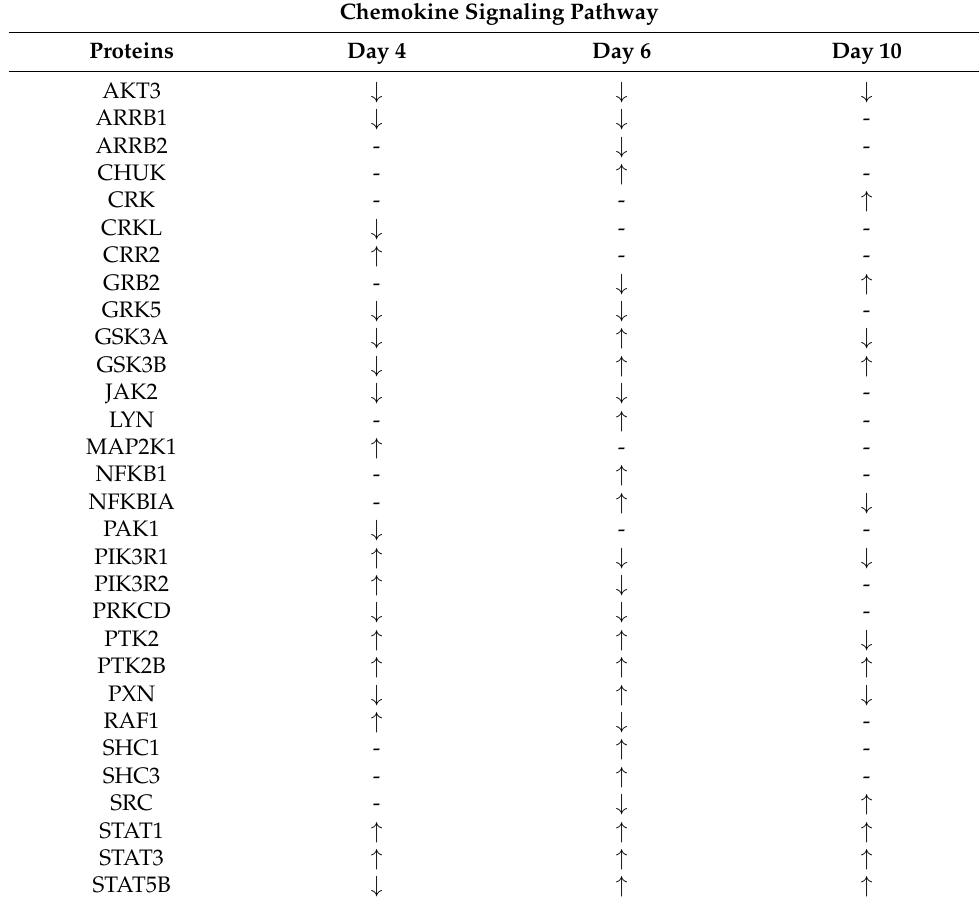
Table 3. Chemokine signaling pathway in chicken ceca on days 4, 6, and 10 of age. The results of this table indicate no clear path utilized by the host immunity of the chemokine signaling pathway other than presence of JAK2 and STAT proteins, which would suggest directionality toward the JAK-STAT